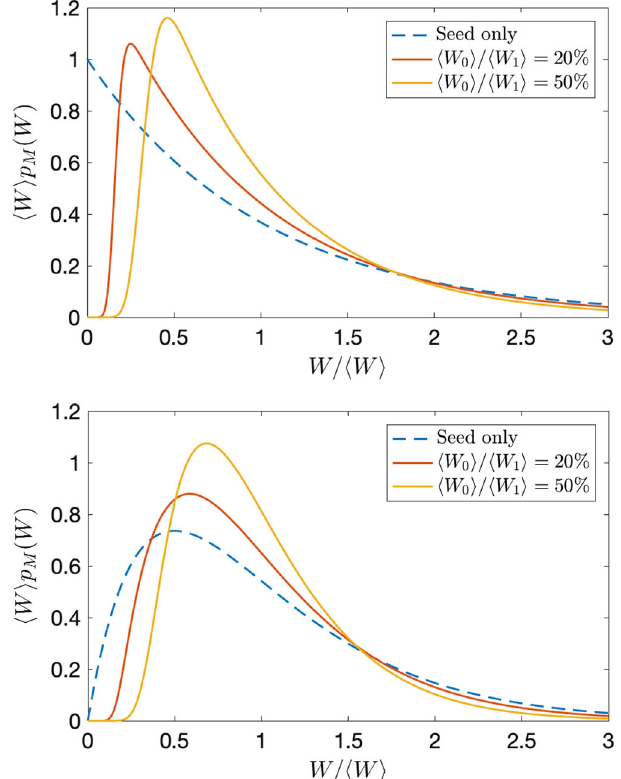
FIG. 5. Total PDF with M 0 ¼ 20 SASE modes and M 1 ¼ 1 seed mode (top) and M 1 ¼ 2 seed modes (bottom). The SASE background increases the likelihood of the radiation energy for a given shot occurring near the mean, and reduces the likelihood of small